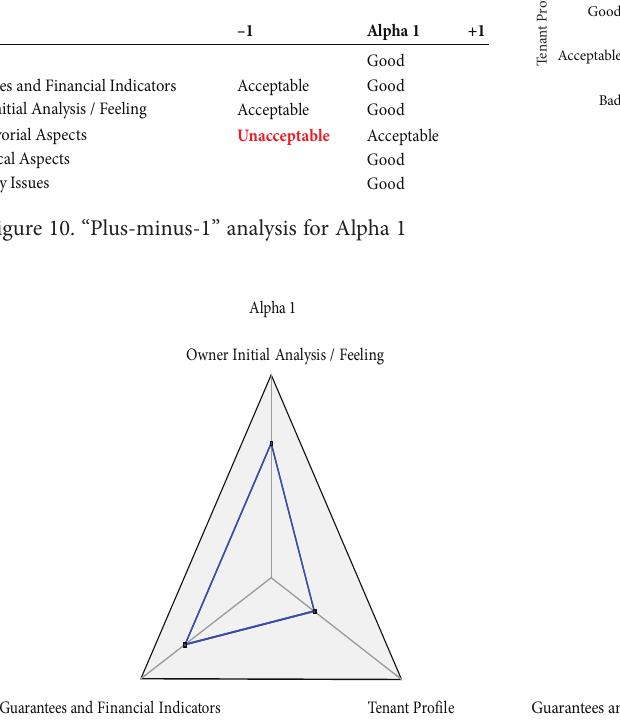
Figure 11. Examples of radar